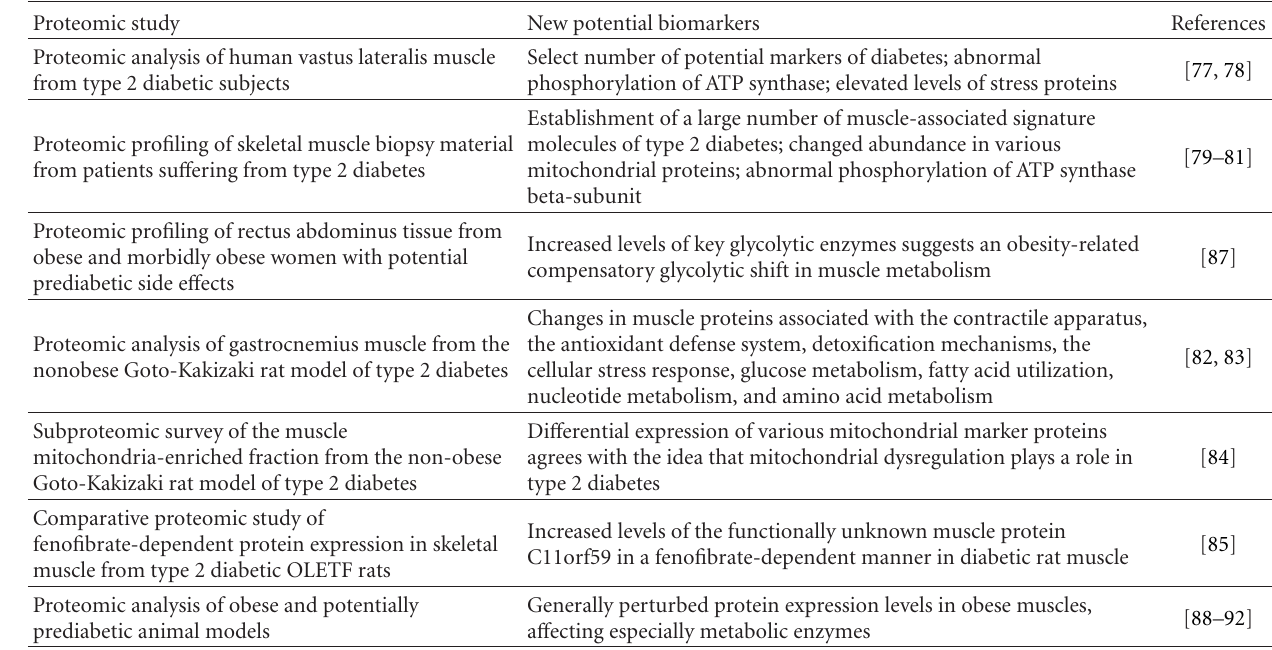
Table 1: List of major proteomic profiling studies of skeletal muscle tissues from prediabetic and diabetic patients or animal models of type 2